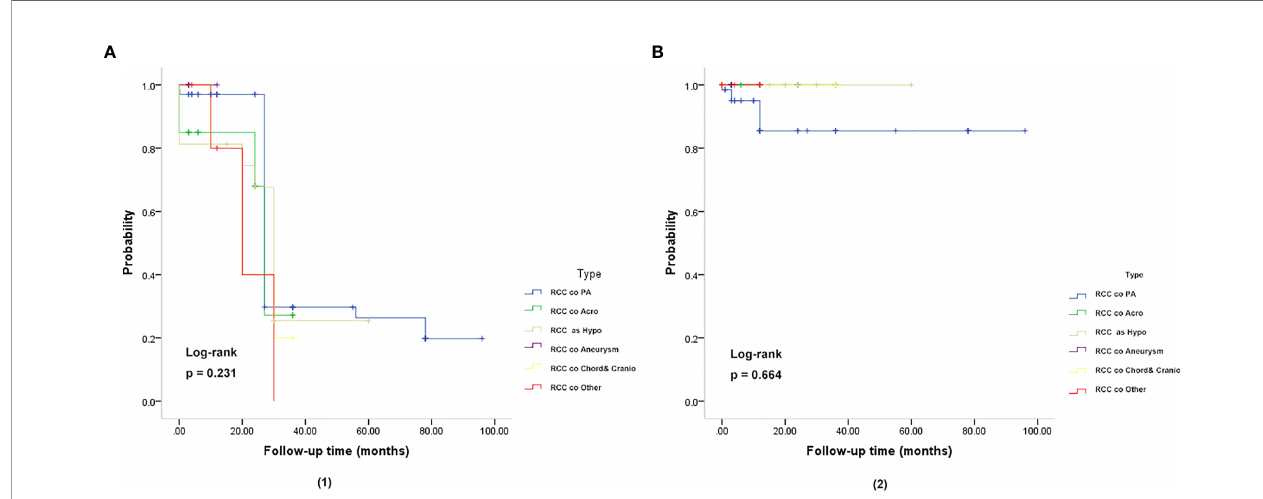
FIGURE 3 | Kaplan-Meier plot for overall survival (OS) (A) and relapse-free survival (RFS) (B) in patients with RCC coexisting with various sellar lesions. ( A , 1): Kaplan-Meier plot for overall survival in patients. The solid blue line represents patients with the coexistence of RCC and PA (n = 67). The solid green line represents patients with the coexistence of RCC and somatotroph adenoma (acromegaly) (n = 20). The solid yellow line represents patient with the coexistence of RCC and hypophysitis (n = 16). The solid purple line represents patients with the coexistence of RCC and aneurysm (n = 4). The solid yellow line represents patients with the coexistence of RCC and chordoma and craniopharyngioma (n = 5). The solid red line represents patients with the coexistence of RCC and other sellar lesions (n = 6) (epidermoid cyst, dermoid cyst, pituitary granulomatosis, salivary tumor, salivary gland remnants). There was no signi fi cant difference in OS and RFS between the six subgroups of patients ( P = 0.231). ( B , 2): Kaplan-Meier plot showing the relapse-free survival (RFS) of patients. There was no signi fi cant difference in OS and RFS among the six subgroups of patients ( P = 0.664). The P -values were obtained by the log-rank (Mantel-Haenszel)